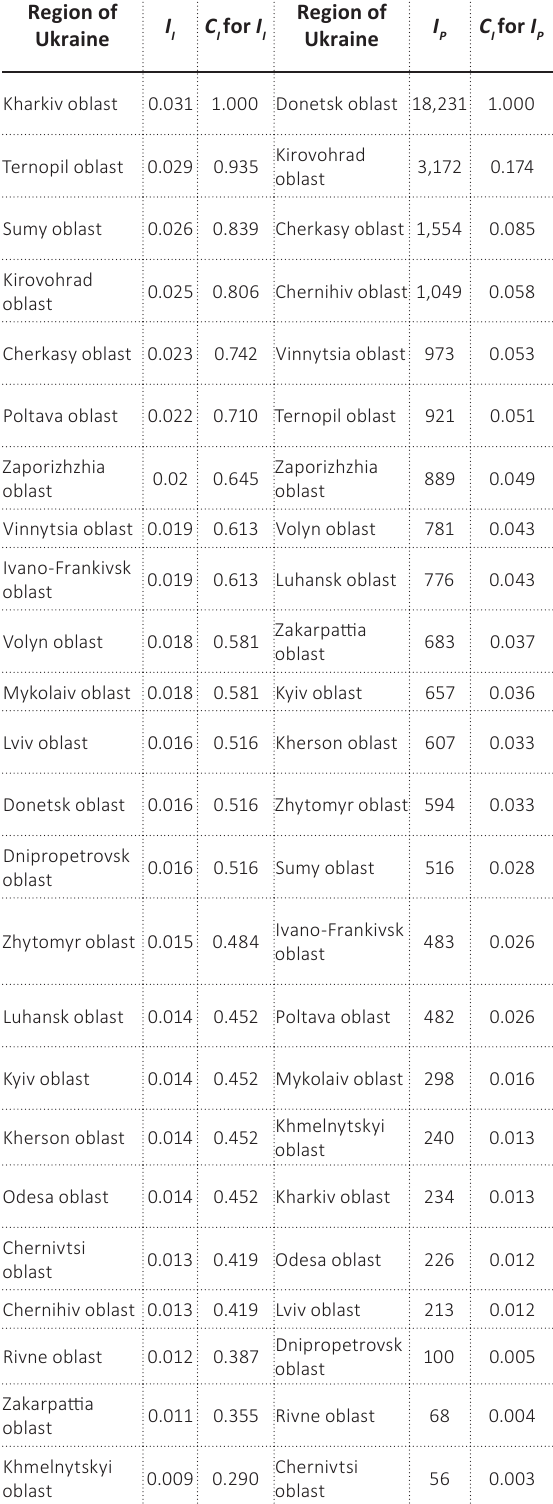
Table 4. Results of calculation of indicators I by regions of Ukraine, 2017‒2019